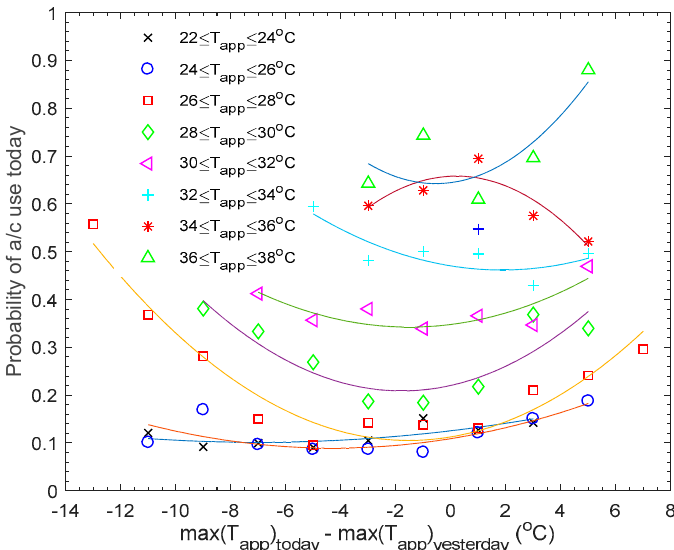
Figure 7. Probability of a/c usage on the given day versus the difference between the given days maximum apparent ambient temperature (T app ), and the maximum apparent temperature on the preceding day for different values of today’s maximum apparent temperature.